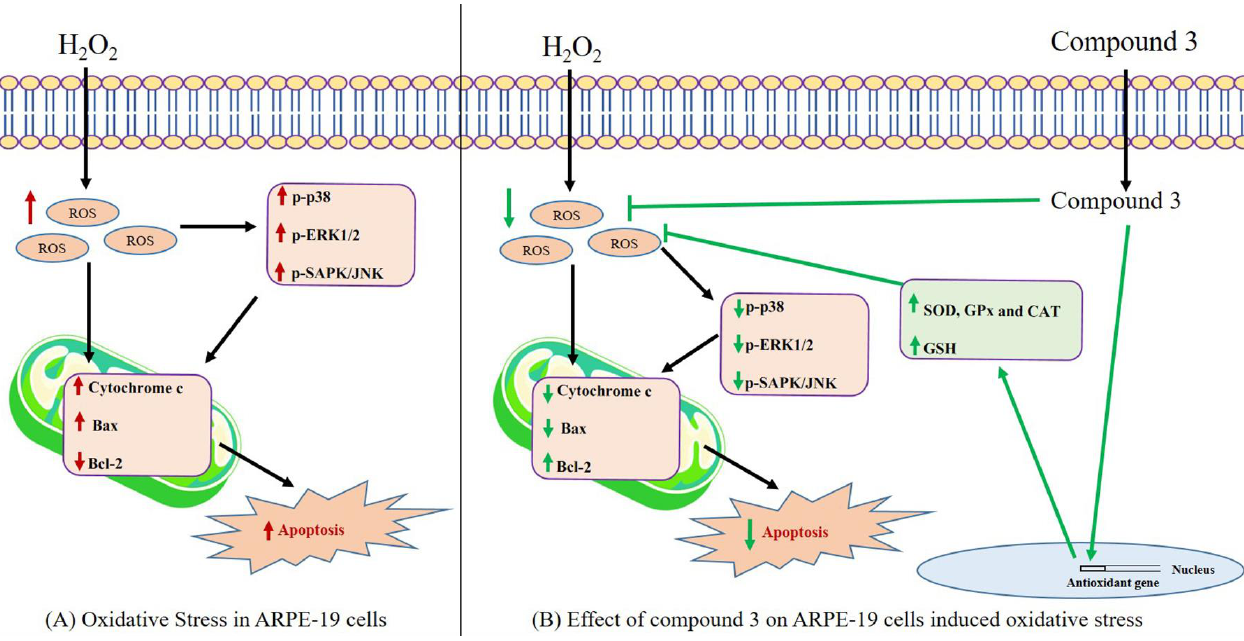
Figure 11. A schematic showed the proposed mechanism. ( A ) H 2 O 2 induces oxidative stress in ARPE-19 cells, which leads to cell death via MAPKs signaling and apoptosis pathways. ( B ) The protective effect of compound 3 on oxidative-stress-induced ARPE-19 cells; pretreatment of compound 3 could protect RPE-19 cells against induced oxidative stress through its ability to scavenge ROS and enhance enzymatic (SOD, GPx, and CAT) and non-enzymatic (GSH) antioxidants.